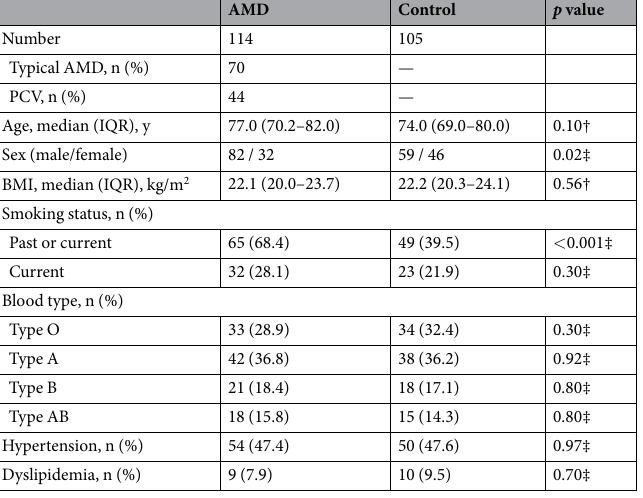
Table 1. Characteristics of patients with AMD and controls. AMD :age-related macular degeneration. PCV :polypoidal choroidal vasculopathy. † Mann-Whitney U test. ‡ Chi-squared